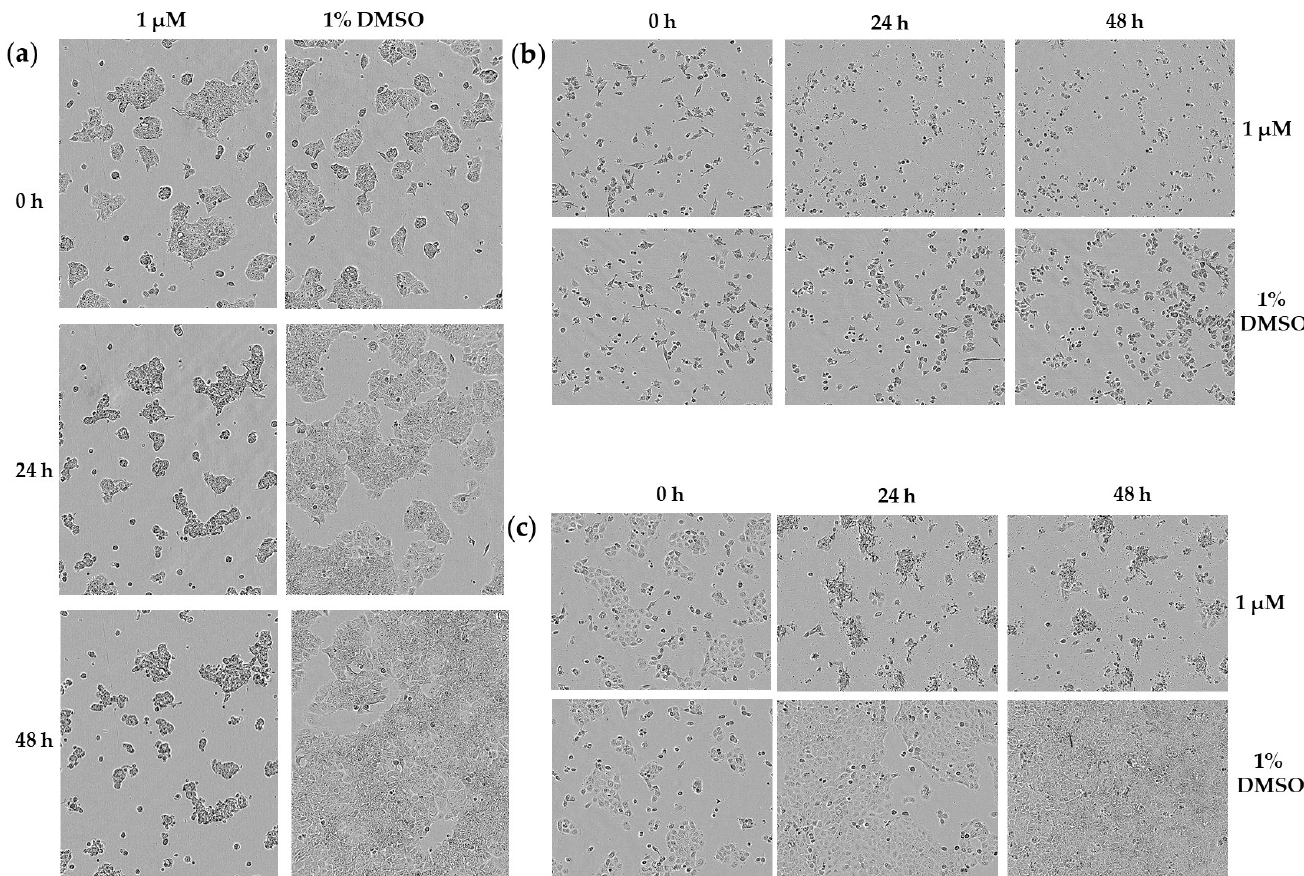
Figure 5. Phase contrast images of ( a ) MCF7 cells, ( b ) A427 cells and ( c ) A431 cells treated with acetoxystachybotrydial acetate in a concentration of 1 µ M and 1% DMSO as control at 0 h, 24 h and 48 h after treatment. Images were taken at tenfold magnification on IncuCyte ® live cell imager.